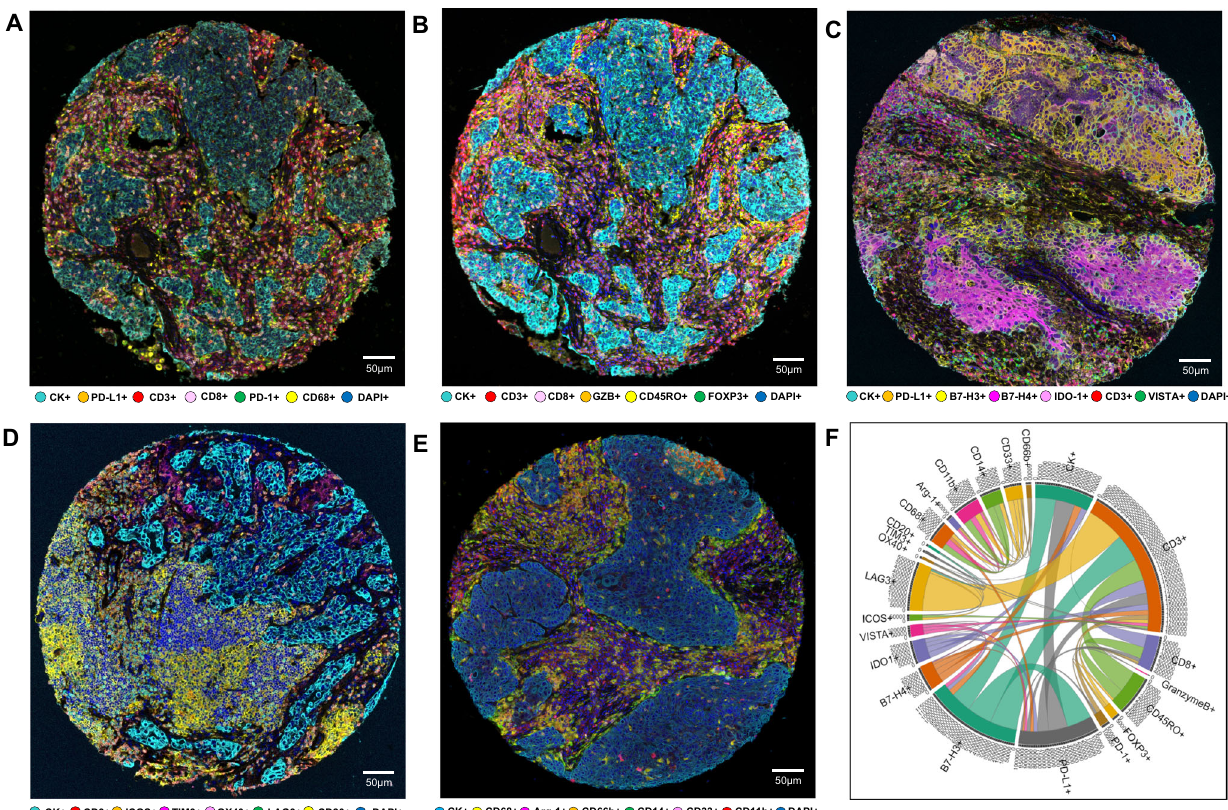
Fig. 1 | Representative examples of multispectral images from non-small cell lung cancer tissue microarray specimens, with their chord diagram of the markers. Composite spectral mixing images from multiplex immuno fl uorescence (mIF;20×magni fi cation,scalebarsrepresent50 µ moneachimage)isshownfor( A ) panel 1: cytokeratin (CK), CD3, CD8, PD-1, PD-L1, and CD68; ( B ) panel 2: CK, CD3, CD8, CD45RO, granzyme B (GZB), and FOXP3; ( C ) panel 3: CK, CD3, PD-L1, B7-H3, B7-H4,IDO-1;andVISTA;( D )panel4:CK,CD3,ICOS,LAG3,OX40,TIM3,andCD20; ( E ) panel 5: CK, Arg-1, CD11b, CD14, CD33, CD66b, and CD68. F Chord